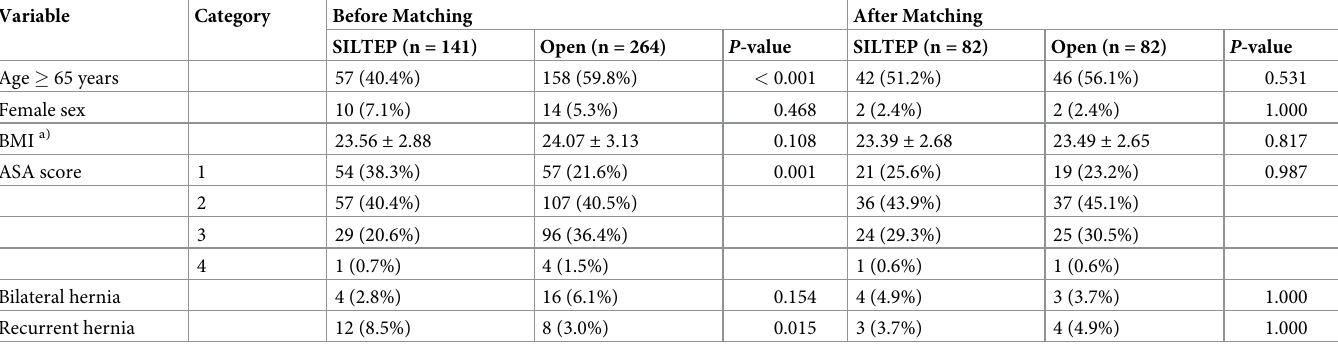
Table 1. Before and after propensity score matching of baseline variables in the SILTEP group versus the open group.